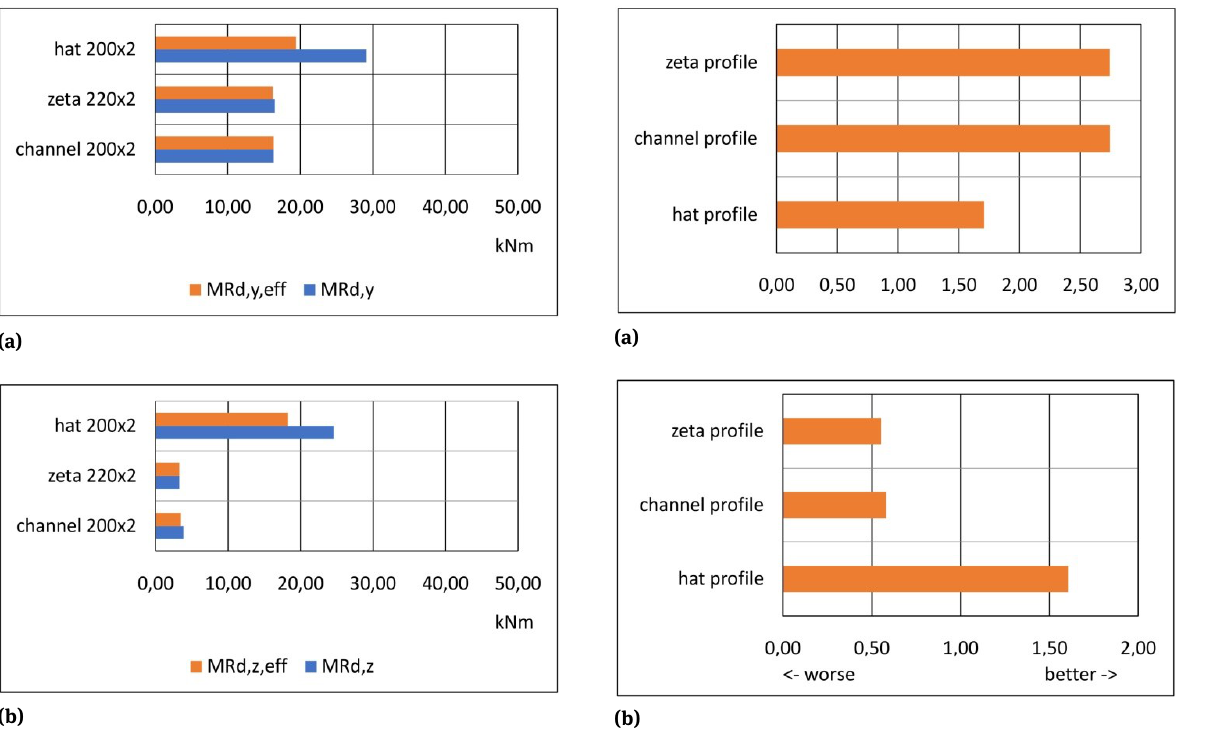
Figure 6: a) The ratio M Rd , y , eff / self-weight of the profile, b) The ratio M Rd , z , eff / self-weight of the